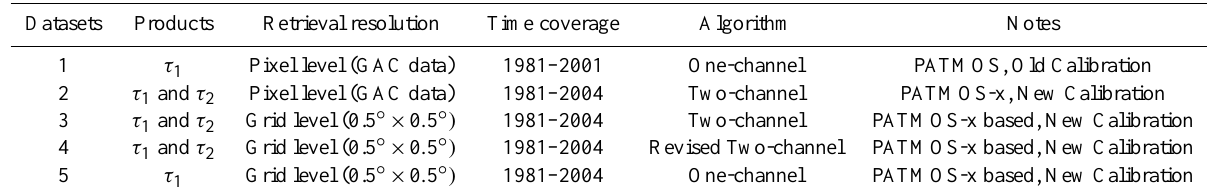
Table 5. Five long term aerosol datasets from the AVHRR observations used in the current AOD tendency analysis. τ 1 and τ 2 are AOD